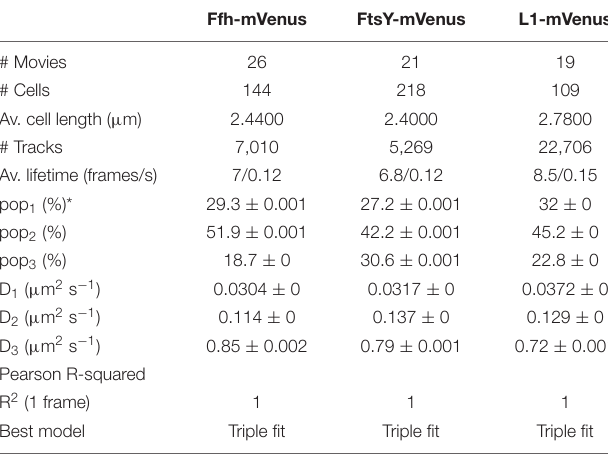
TABLE 1 | Squared displacement